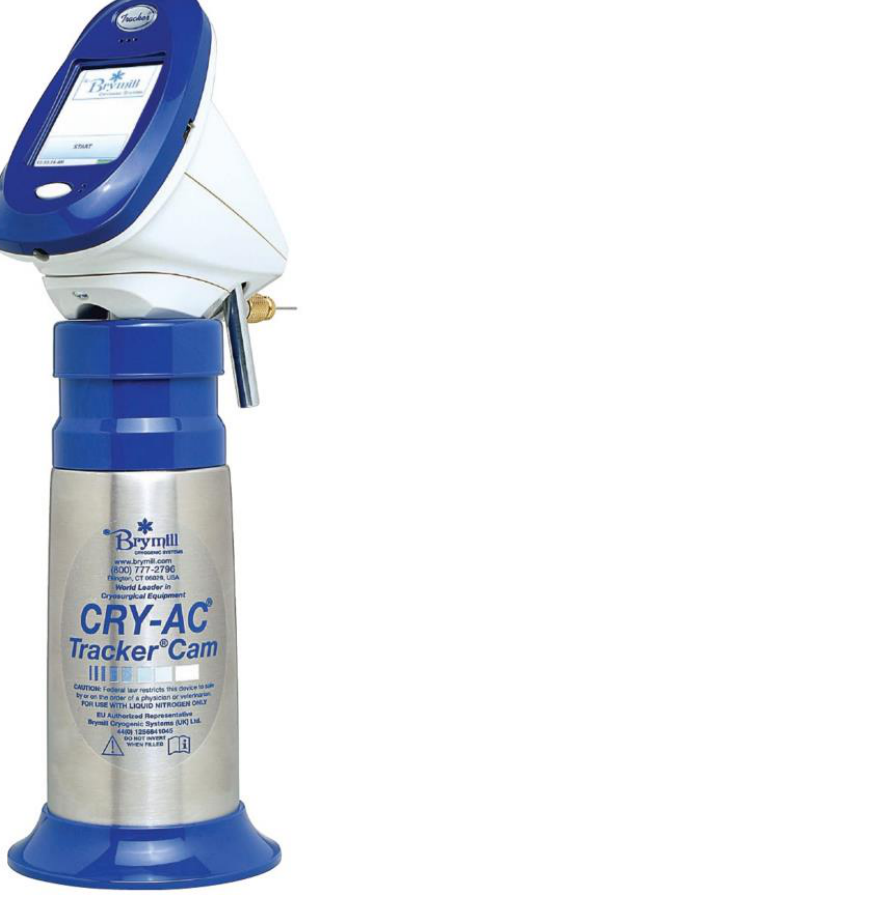
Figure 6. An updated cryotherapy device (Cry-Ac Tracker Cam) that measures the skin temperature when spraying liquid nitrogen on the selected skin lesion using an infrared sensor. The operator can set the device to indicate when a predetermined freeze temperature has been achieved at the lesion (courtesy of Brymill Cryogenic Systems, Ellington,